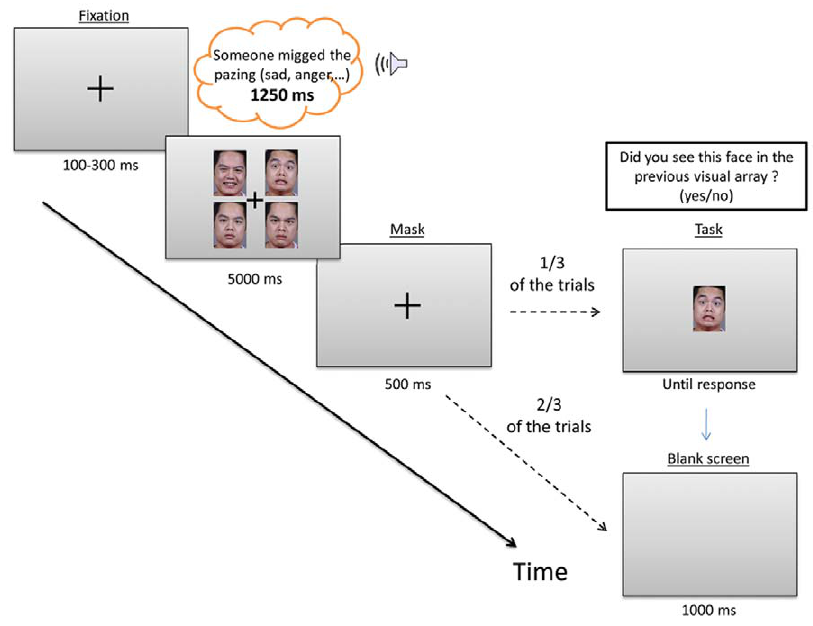
Figure 1. Illustration of the visual array used in this study and of the trial sequence.